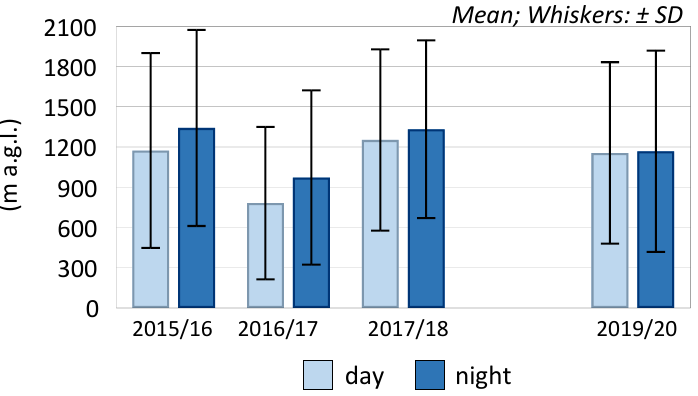
Figure 4. The base of the first (located at the lowest level) ELI